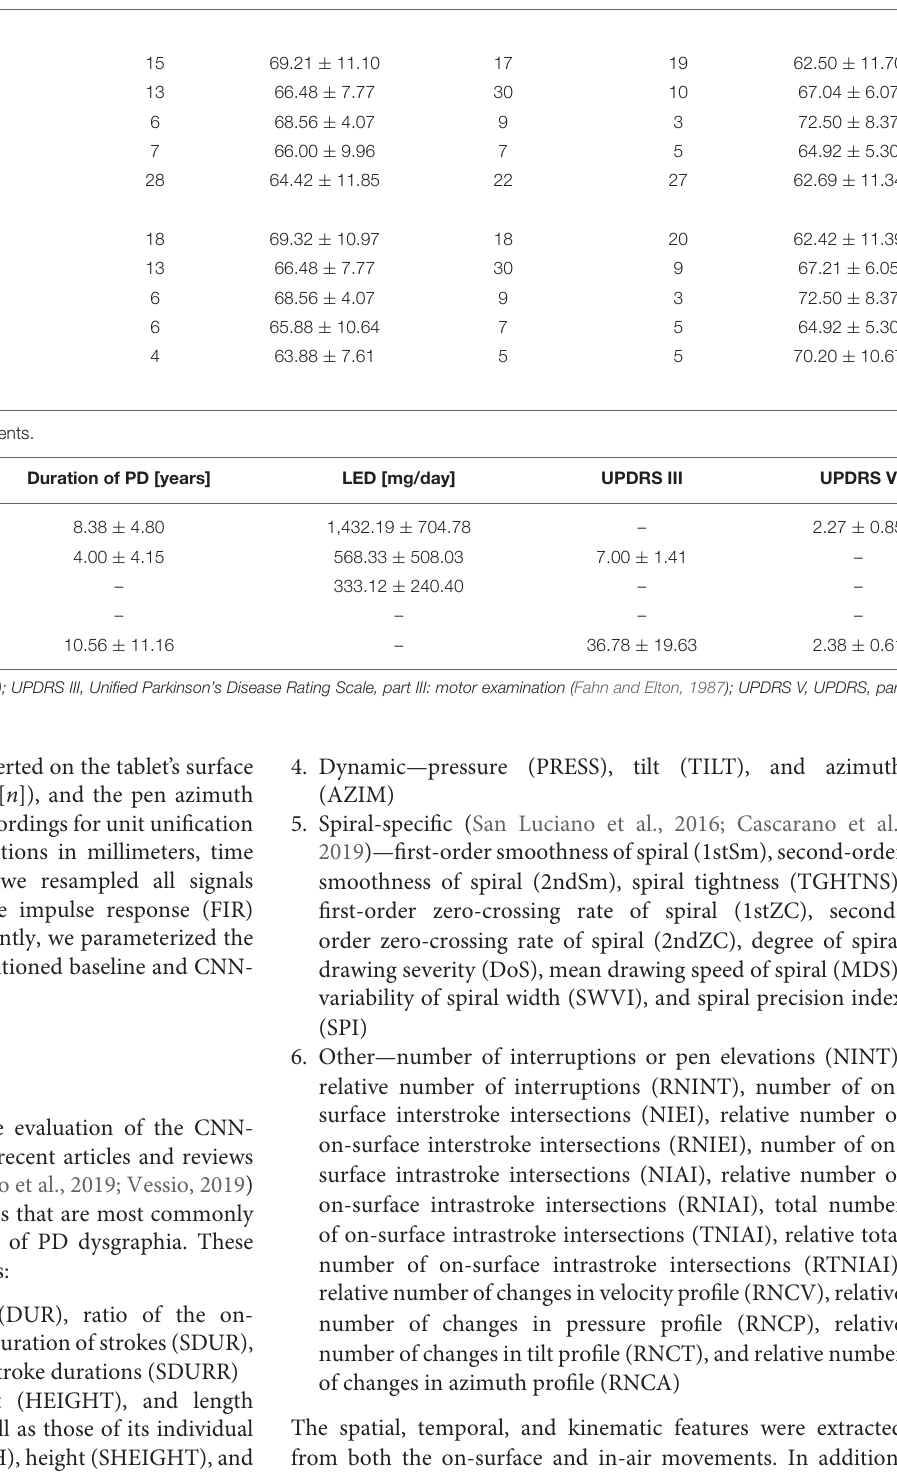
TABLE 2 | Demographic characteristics. Dataset